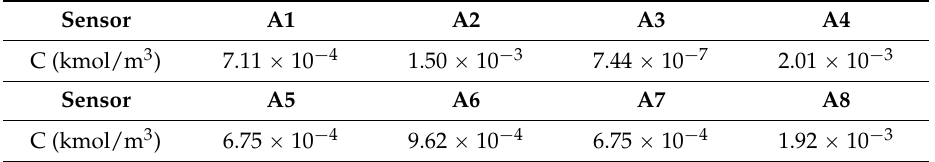
Table 14. The measured concentration of deployment scheme based on PSO algorithm.